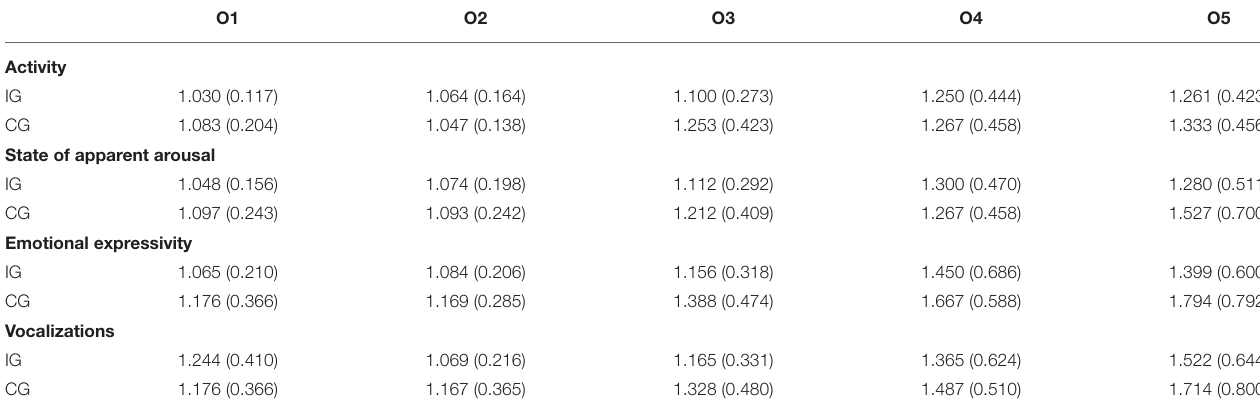
TABLE 4 | M (SD) of the mYPAS measures at the respective observation points. O1 O2 O3 O4 O5